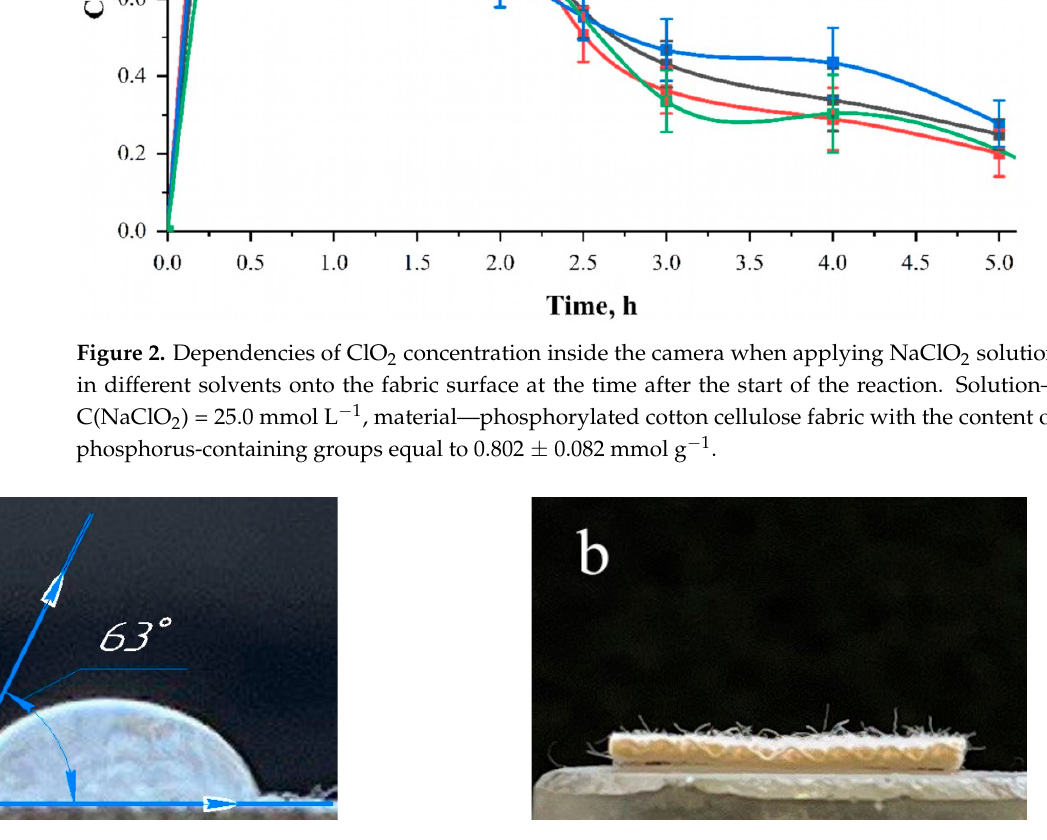
Figure 2. Dependencies of ClO 2 concentration inside the camera when applying NaClO 2 solution in different solvents onto the fabric surface at the time after the start of the reaction. Solution— C(NaClO 2 ) = 25.0 mmol L –1 , material—phosphorylated cotton cellulose fabric with the content of phosphorus-containing groups equal to 0.802 ± 0.082 mmol g –1 .